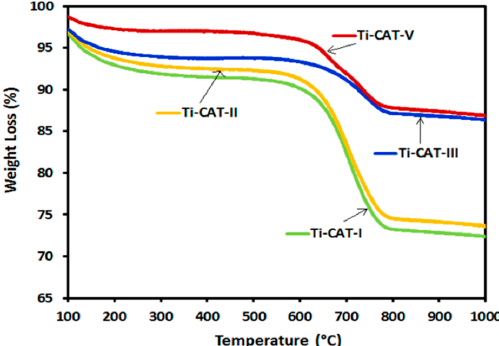
Figure 7. TGA profiles for the spent catalysts.